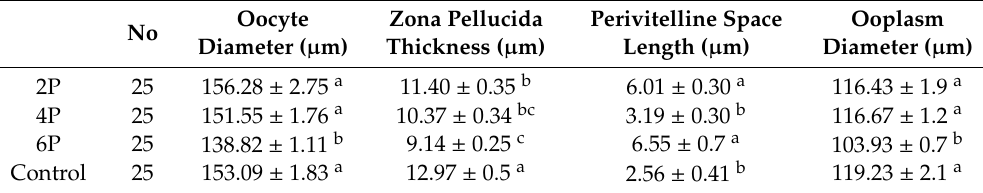
Table 3. E ff ect of ROCK inhibitor on camel oocyte